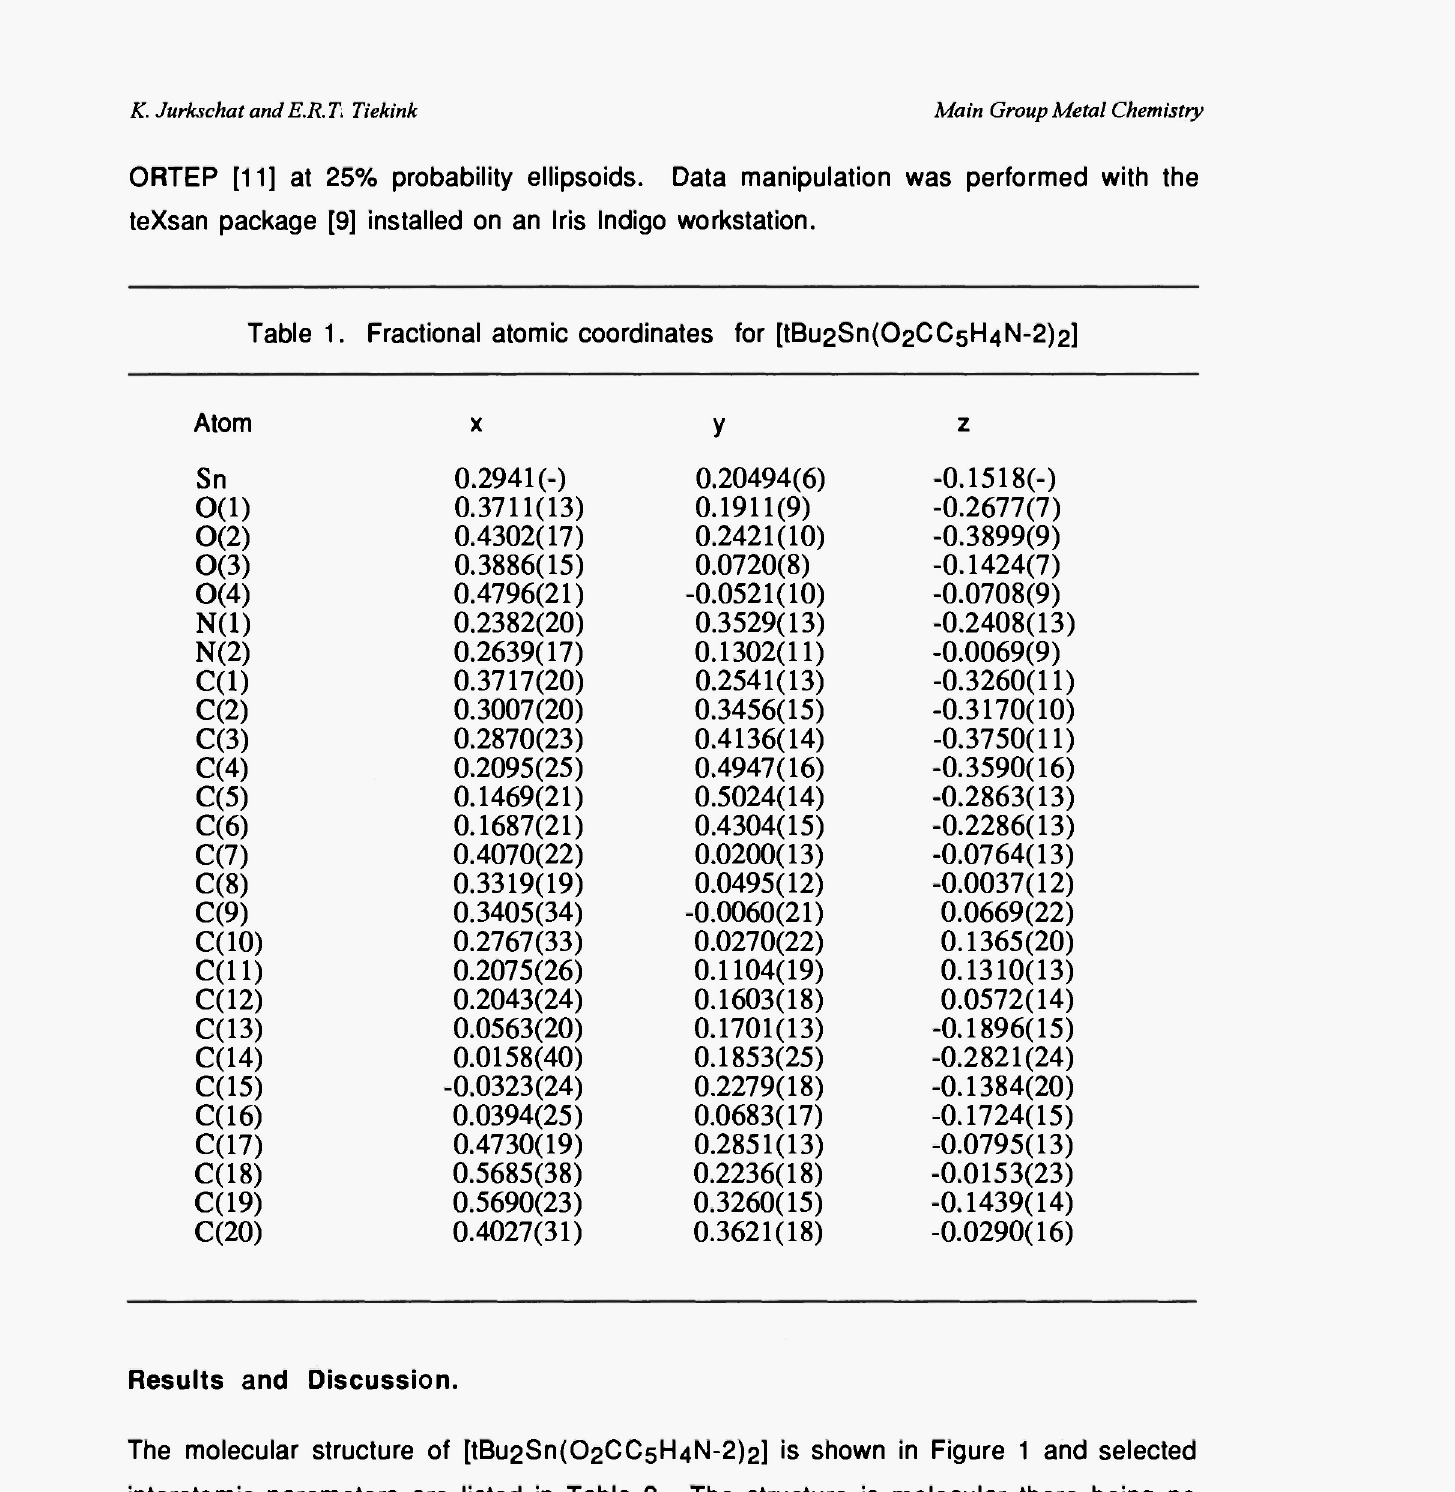
Table 1. Fractional atomic coordinates for